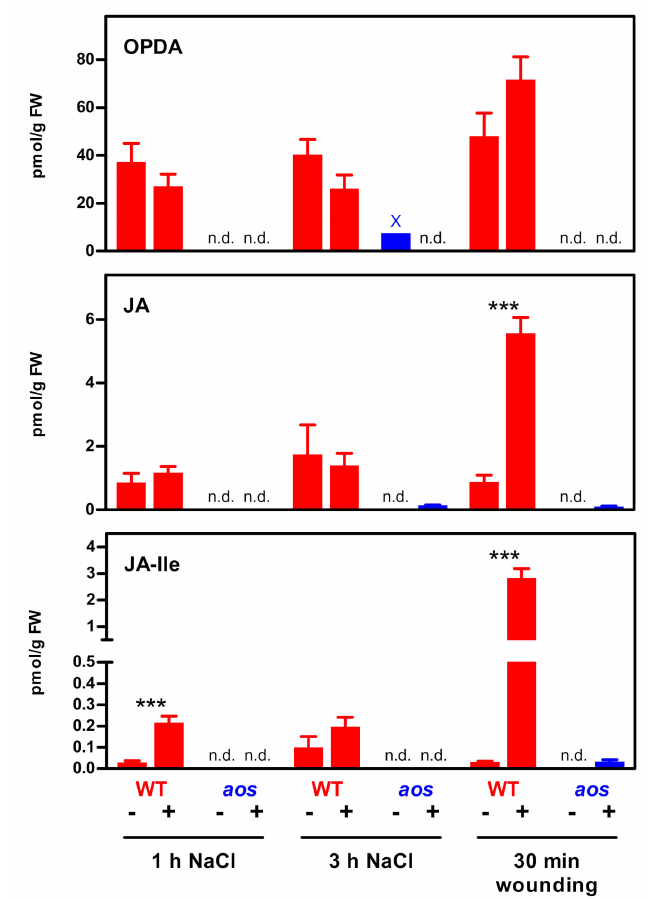
Figure 1. The cis -( + )-12-oxo phytodienoic acid (OPDA), ( + )-7- iso -jasmonic acid (JA) and jasmonoyl- isoleucine (JA-Ile) levels in roots of Arabidopsis thaliana wild-type and allene oxide synthase ( aos) plants upon NaCl treatment and after wounding. Data are mean values ± SEM of four (wild-type) or three ( aos ) samples, each representing pooled root tissue from two individual plants. Asterisks denote statistical significance between control and treated samples (unpaired, two-tailed t -test. *** p < 0.001). The OPDA value for the three-hour NaCl treatment of aos plants (marked with a cross) was obtained from one sample, whereas no OPDA was detected in the other two extracts. n.d.; not